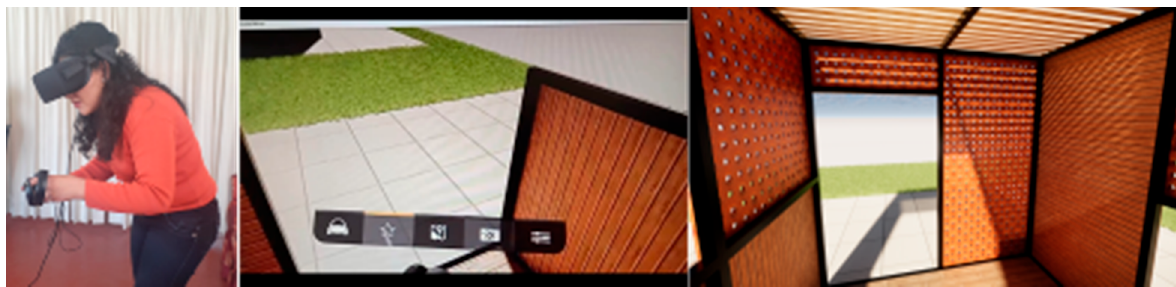
Figure 10. Immersion in architectural spaces.